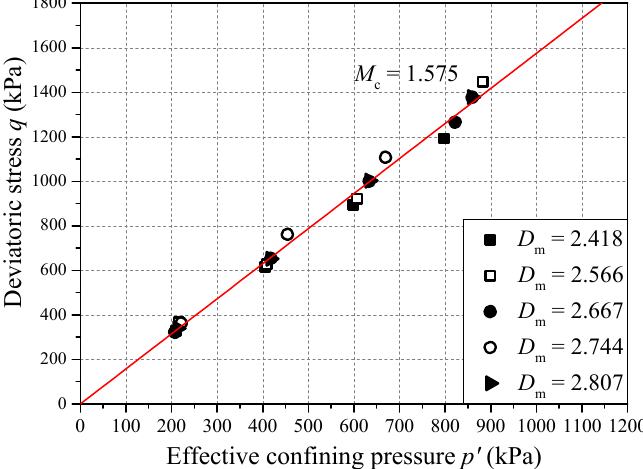
Figure 7. The critical state line in the q – p ′ plane of the calcareous sand with different fractal dimensions. 3.4. Influence of the Fractal Distribution of Particle Size on the Critical State Line in the e–p (cid:48) Plane of the Calcareous Sand